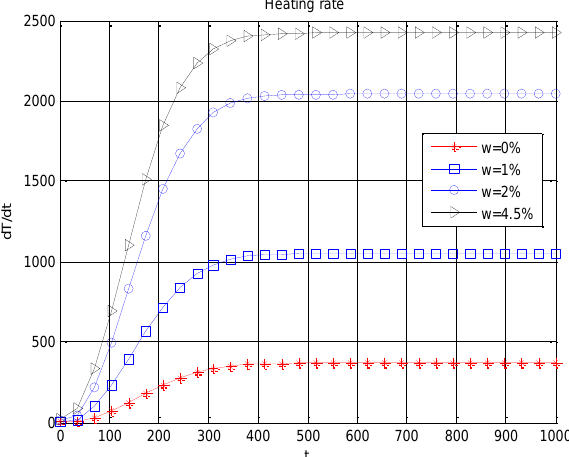
Figure 8: Heating rate of sodium chloride with different water con- tent at 2.45 GHz microwave